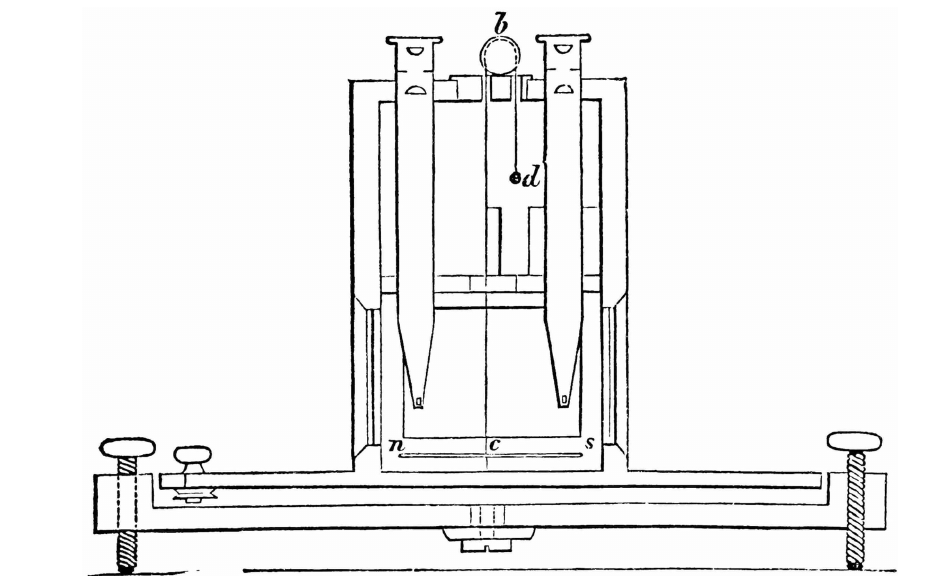
Figure 7. This is the diurnal variation instrument designed by George Dolland and manufactured around 1825 (Multhauf and Good, 1987) that was used for recording declination changes. A similar instrument existed at Colaba and later on at